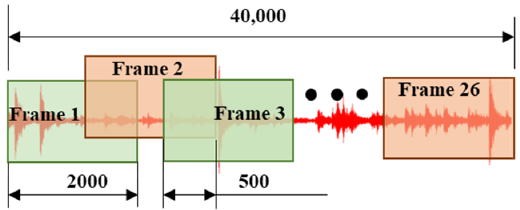
Figure 3. AE sample segmentation.